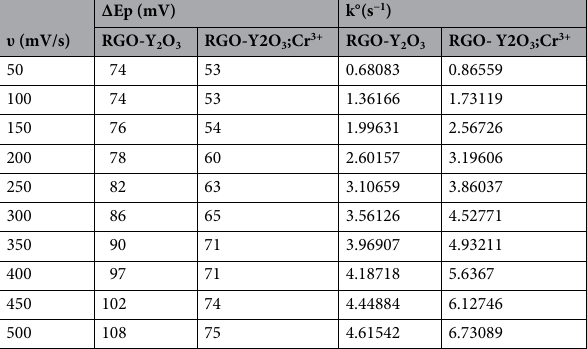
Table 1. The rate constant values for DA at different sweep